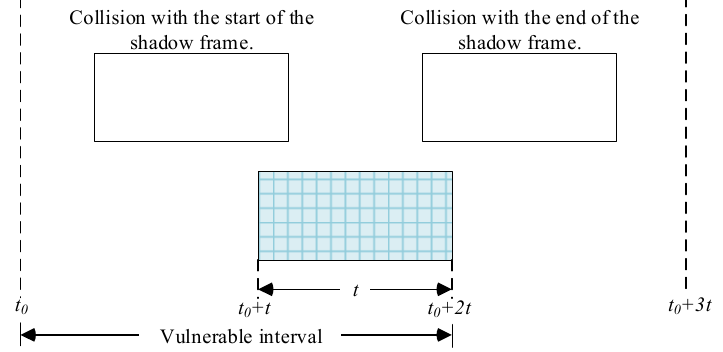
Figure 3. The working principle of pure ALOHA.